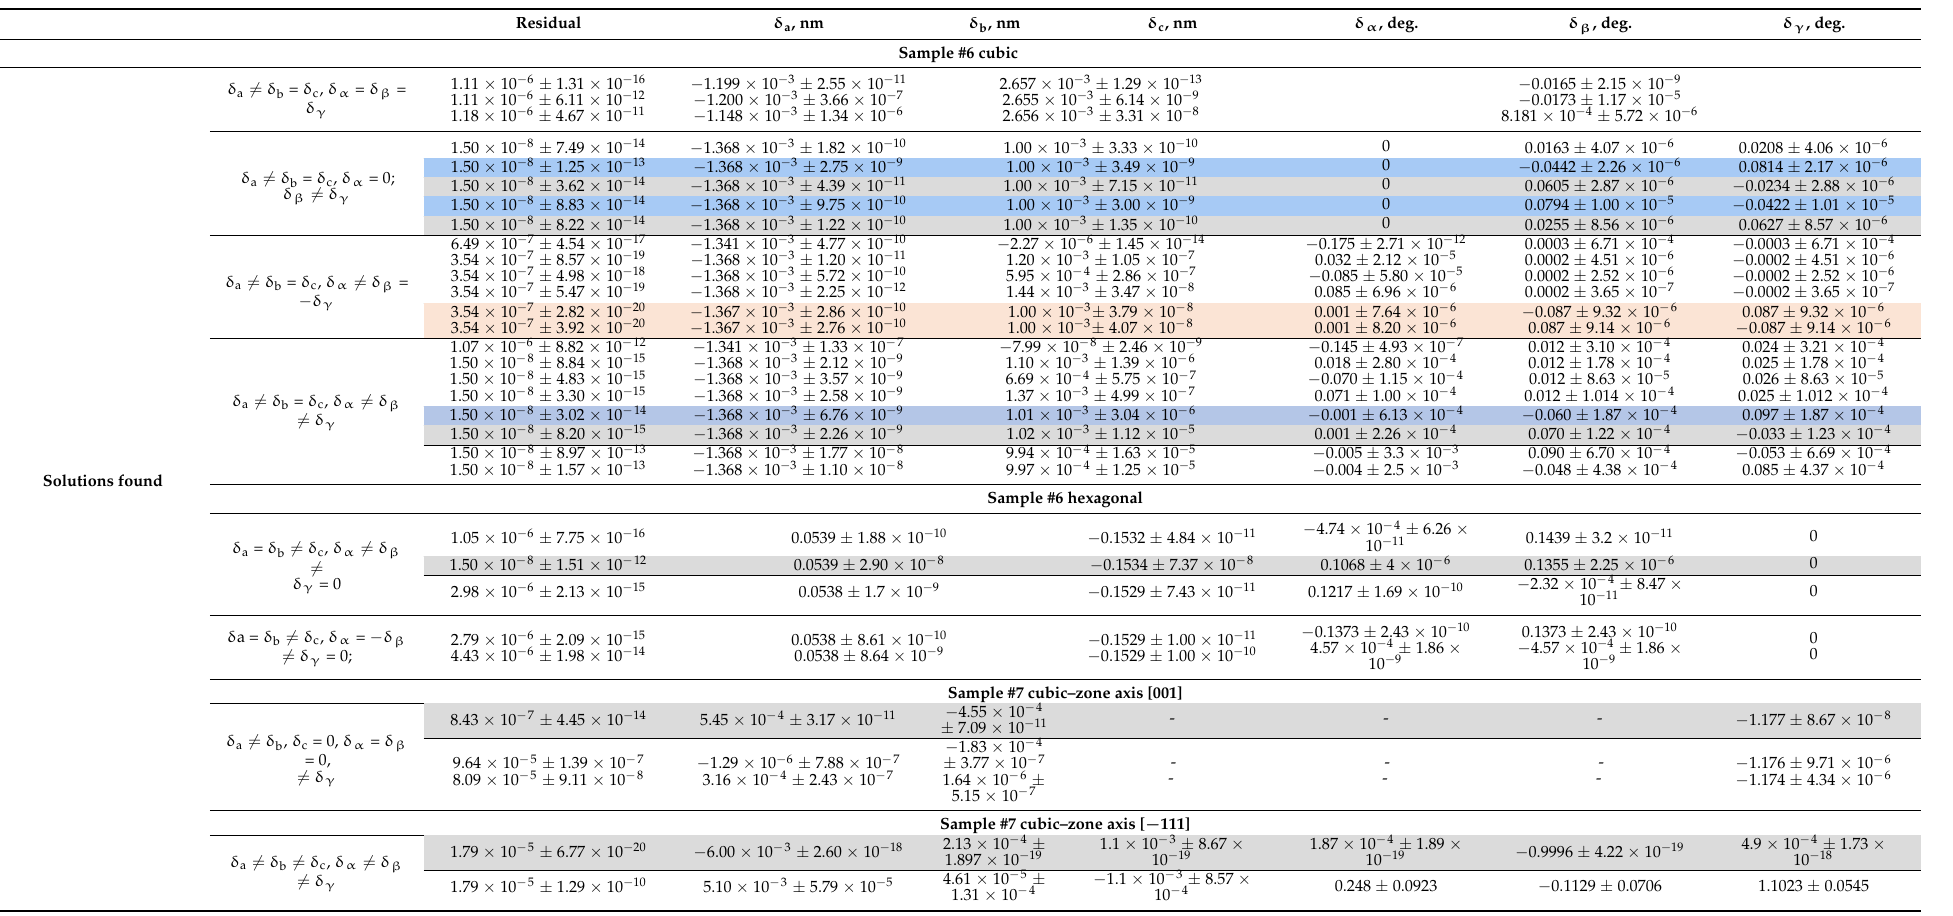
Table 2. Solutions for lattice distortions for the Fe 3+ x Si 1 − x epilayer of sample #6 and two crystallites of sample #7. Configurations of crystal lattice distortions are given in the table. The sign of ± indicates the standard deviation from the average value of the 200 solutions with the minimal residual function